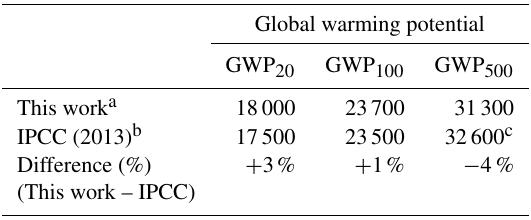
Table 6. Comparison of 20-, 100- and 500-year global warming potentials for SF 6 from this work with values from IPCC (2013). Global warming potential GWP 20 GWP